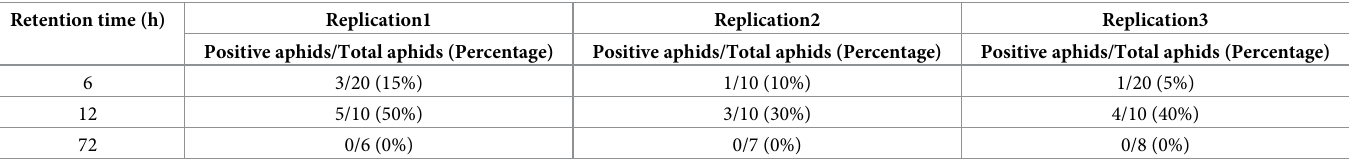
Table 2. Retention of CGMMV in M . persicae